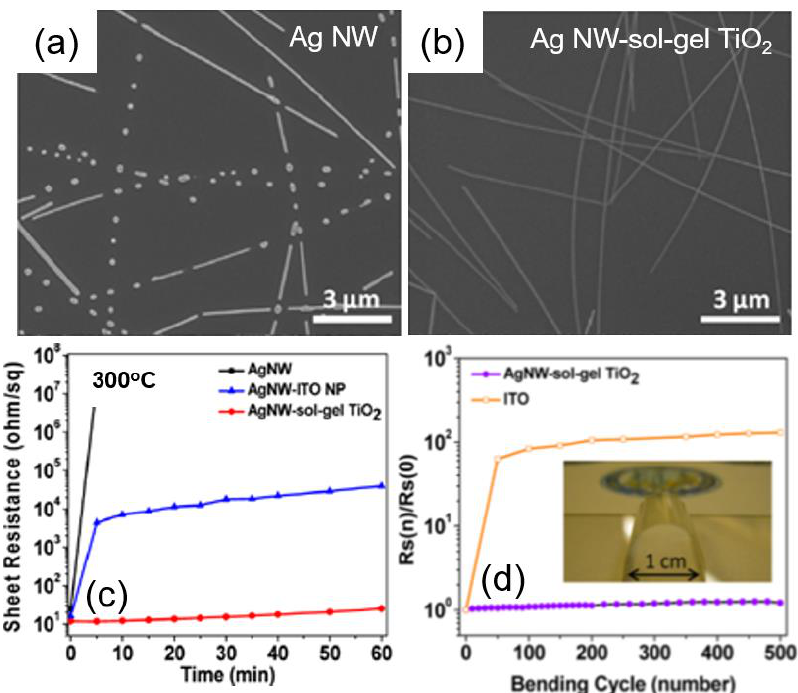
Figure 19. SEM images of ( a ) Ag NW network (300 °C) and ( b ) Ag NW − sol − gel TiO 2 film (300 °C). ( c ) Sheet resistance of Ag NW network and Ag NW composites (Ag NW − ITO NPs and Ag NW − sol −